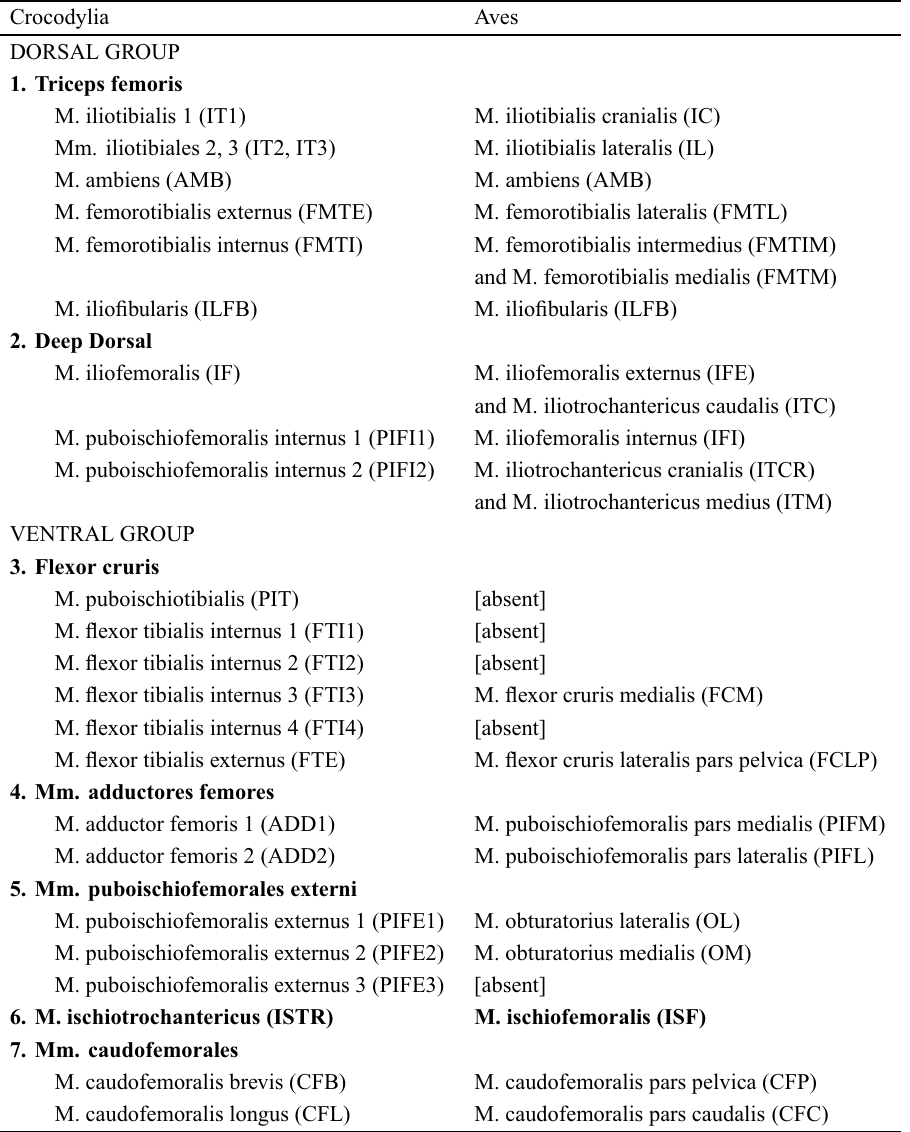
Homologies of the hind limb muscles in extant archosaurs (Modified from Hutchinson [2001a, 2002] and Carrano and Hutchinson [2002]). Although some variability exists within birds and crocodilians regarding muscle size, shape, and even presence, the condition listed represents the inferred condition for the common ancestor of each group (Carrano and Hutchinson